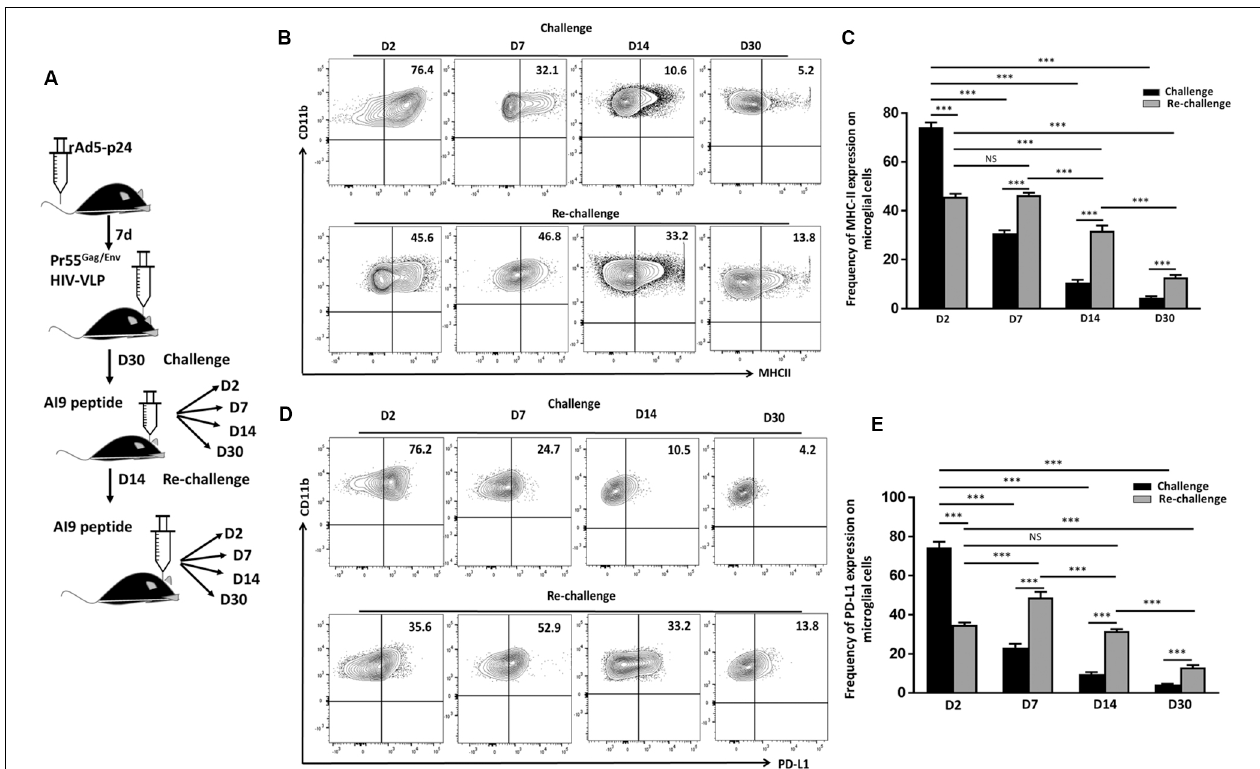
FIGURE 2 | In vivo re-challenge with T-cell epitope peptide-induced long-term microglial cell activation. (A) Schematic design of AI9 peptide injection into the brain and tissue collection at d 2, 7, 14, and 30 post in vivo challenge and re-challenge. (B) Contour plots present MHCII expression on CD45 int /CD11b + microglial cells at the indicated time points post-challenge and re-challenge. (C) Bar graph presents the pooled frequency (as a percentage) of MHCII expression on microglia at d 2, d 7, d 14, and d 30 post-challenge and re-challenge. (D) Representative contour plots present expression of PD-L1 on microglia at d 2, 7, 14, and 30 post-challenge and re-challenge. (E) Bar graph presenting pooled data of the percentage of PD-L1 expression on microglial cells. Data presented are representative of two independent experiments using six animals/group/time point (i.e., two brains pooled together). P values were derived from one-way ANOVA statistical testing. ∗∗∗ p < 0.001; non-significant (NS) represent groups with no significant differences.